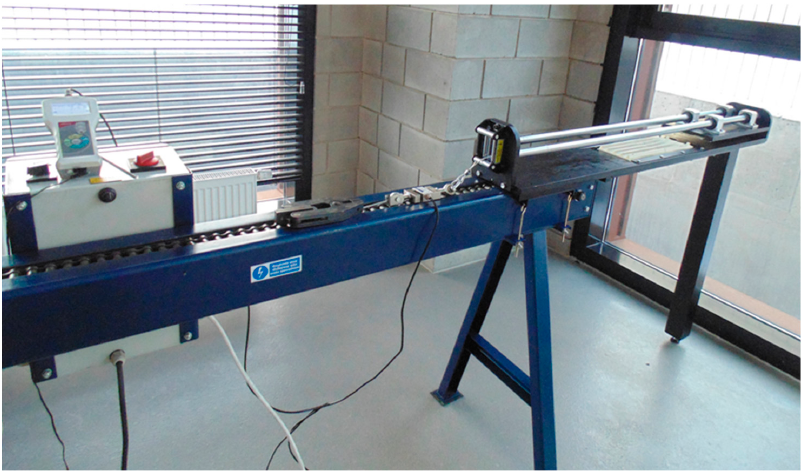
Figure 2. Laboratory stand for cross rolling of model material with an emphasized rolling module.